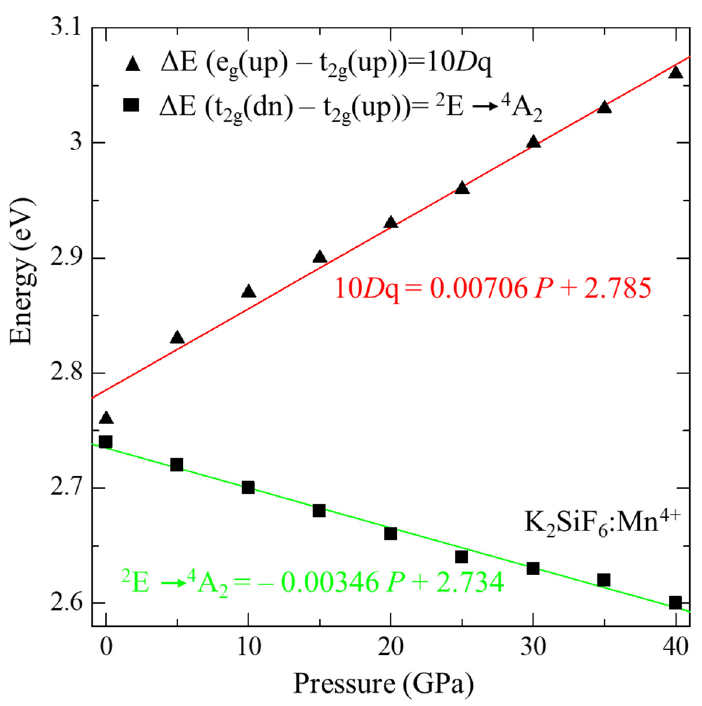
Figure 7. Calculated emission energy, E em , and 10 Dq for Mn 4+ -doped K 2 SiF 6 as a function of pressure. The solid lines are the least-square linear fittings.